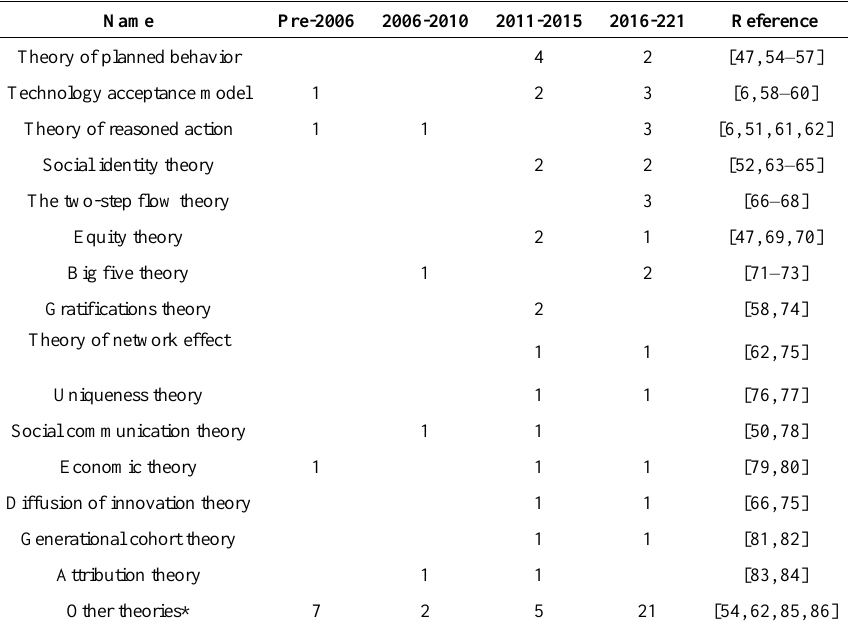
Table 1. Summary of theories applied in the sample literature